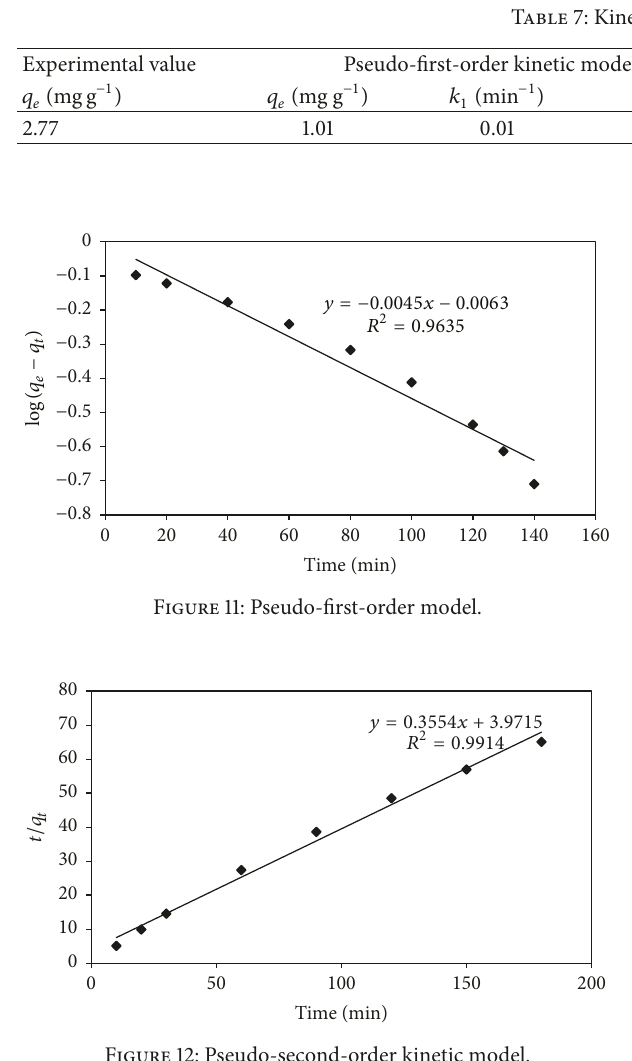
Figure 12: Pseudo-second-order kinetic model.